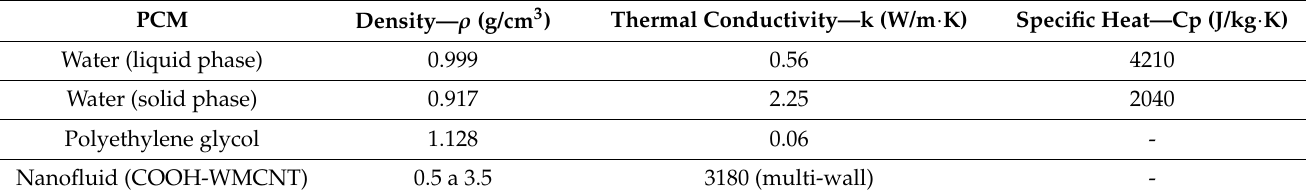
Table 2. Properties of PCMs